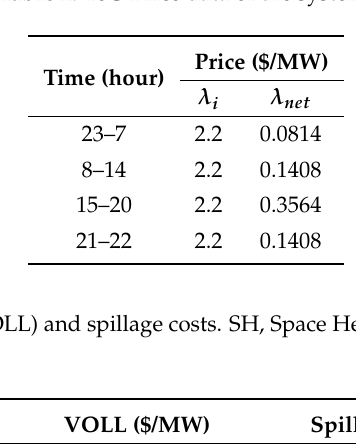
Table 2. ToU Price data of the system.